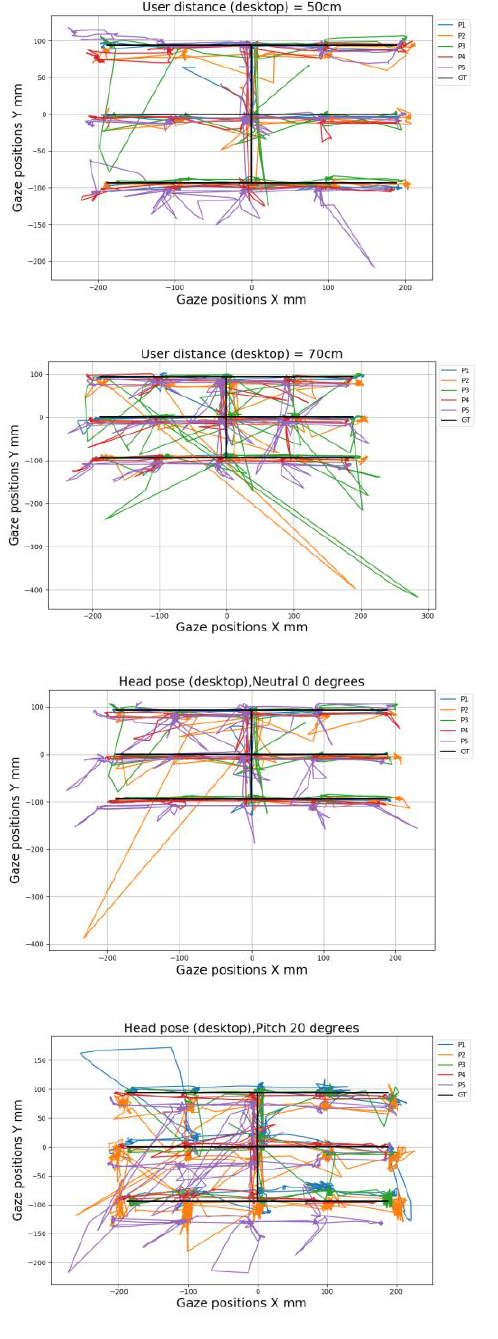
Figure A1. Gaze data from desktop-based user distance and head pose experiments.